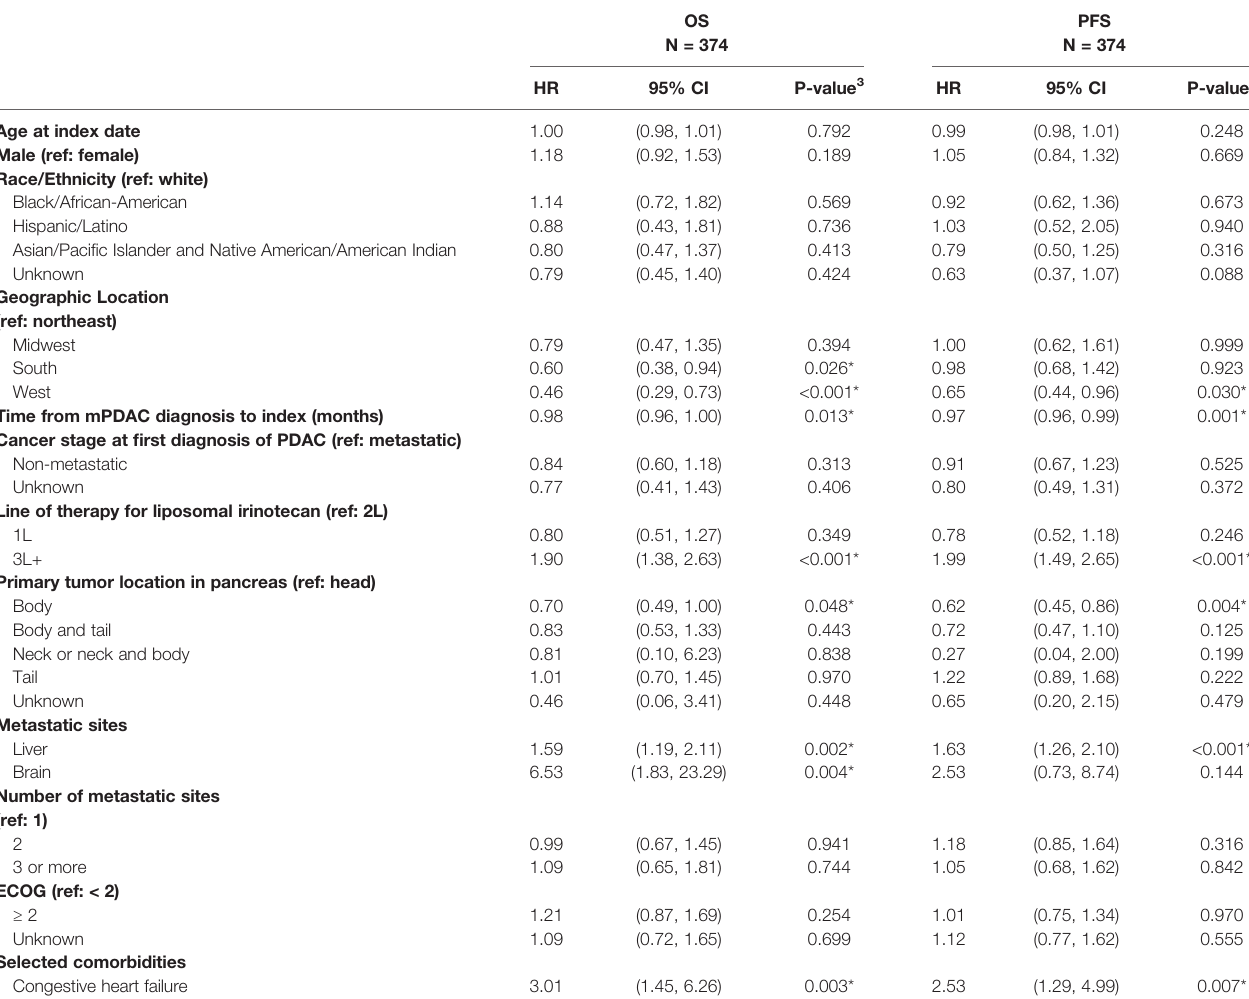
TABLE 4 | Associations between Baseline Characteristics and Effectiveness Outcomes of Liposomal Irinotecan - Multivariate Analysis.